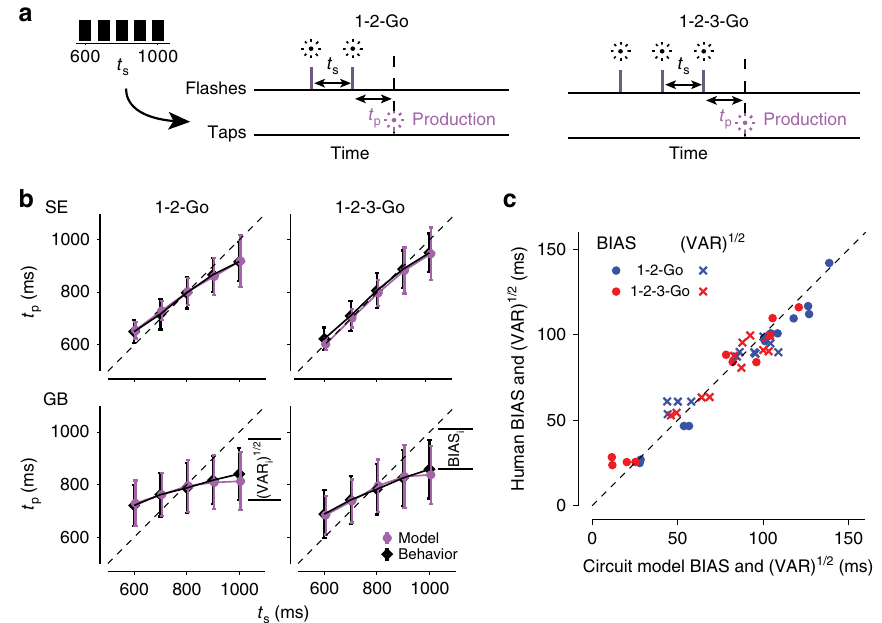
Fig. 7 Bayesian behavior of the synchronization model. a Schematic diagram of the interval reproduction task. In each trial, subjects were asked to produce an interval ( t p ) that matched an interval sampled ( t s ) from a set prior distribution (left). In 1-2-Go trials (middle), subjects observed two fl ashes (vertical magenta lines) demarcating t s . In 1-2-3-Go trials, subjects observed three fl ashes (vertical magenta lines) demarcating t s twice. b Behavior of two example subjects (black) on the 1-2-Go and 1-2-3-Go tasks, together with the circuit fi t to each subject (magenta). Error bars represent standard deviation across trials, n = 100 simulated trials for each t s . Behavioral data modi fi ed from Egger and Jazayeri 31 . c Observed BIAS and VAR of nine subjects compared to the BIAS and VAR of the circuit model fi t to each subject. Circles indicate BIAS, crosses VAR, and the color indicates the trial type. Dashed line represents